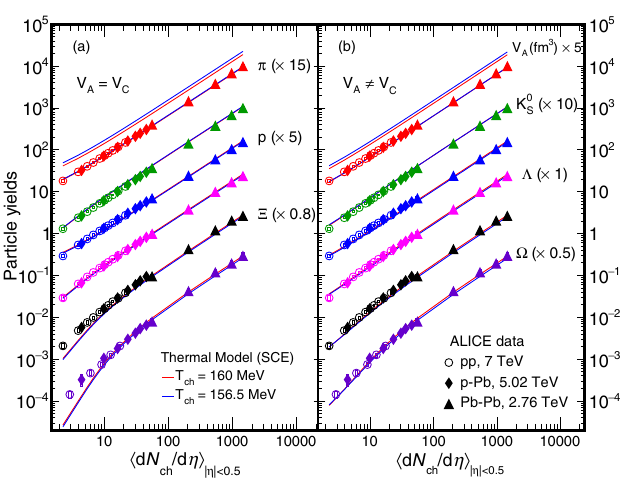
Figure 2. Left: Yields for V A = V C . Right: Yields for V A (cid:31) V C , The two top lines are the fitted volumes V A (x5) in fm 3 . The particle yields are indicated together with the multiplicative factor used to separate the yields. The solid blue lines have been calculated for T = 156.5 MeV while the solid red lines have been calculated for T = 160 MeV. The values of the volumes used have been parametrized empirically (see text for more